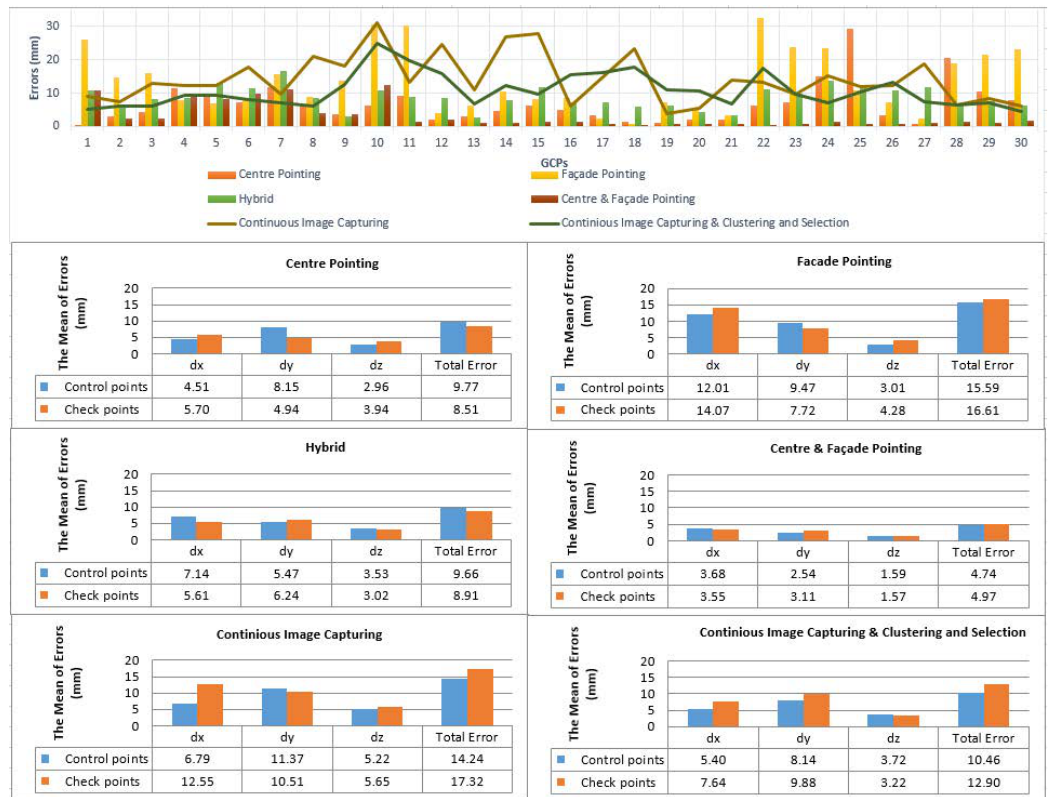
Figure 24. The errors of GCP coordinates for all four approaches ( top ). The mean of errors of the control and check points in X, Y and Z directions and the total errors for all approaches ( bottom